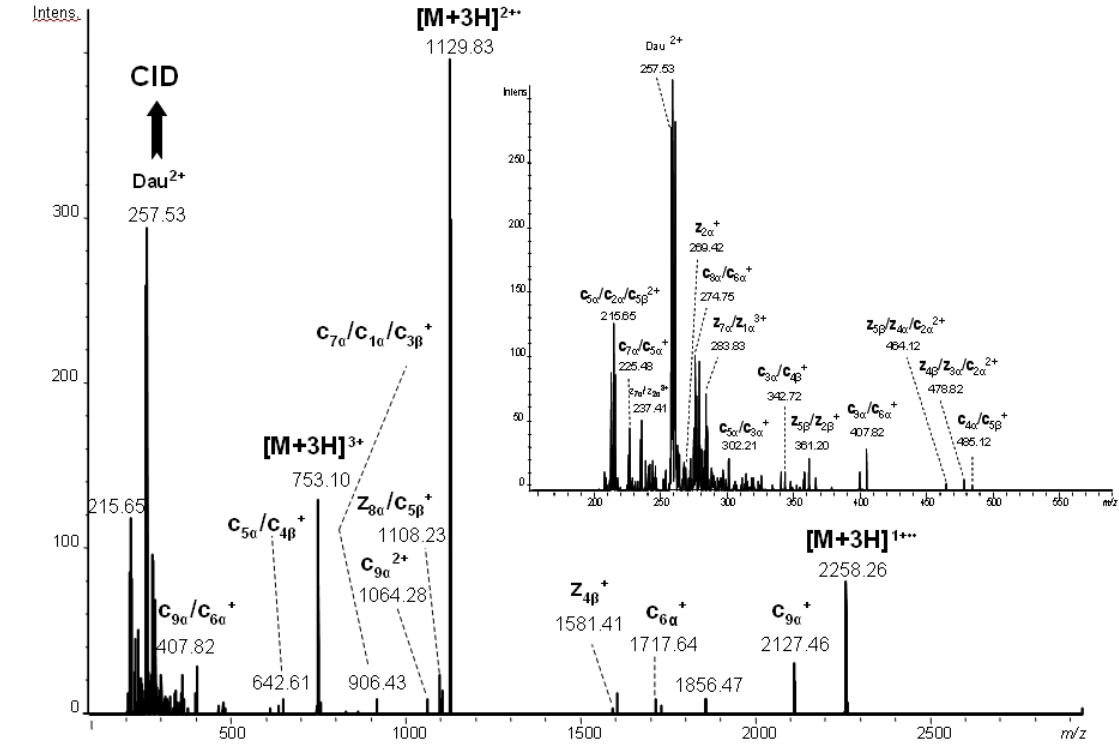
Figure 4. NanoMate-ETD MS 2 of the [M+3H + ] 3+ ion at m/z 753.10 corresponding to Dau-GnRH III. Inset: zoomed m/z (200-500) area. Acquisition time 30